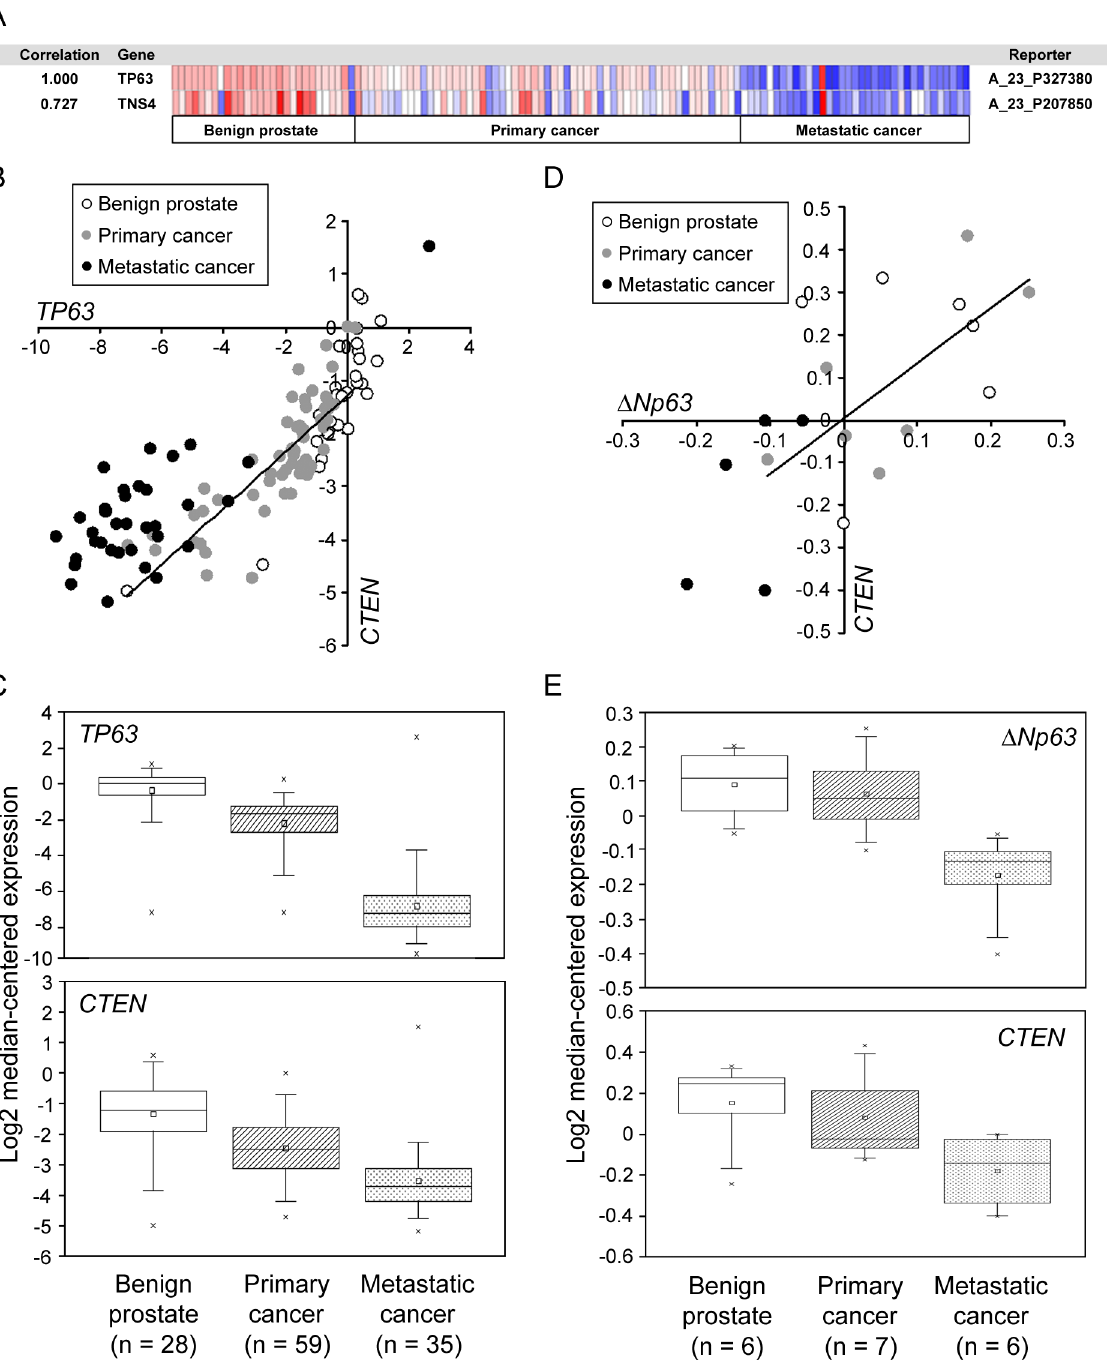
Fig 1. Positive correlation between p63 and CTEN expression in human prostate tissues. (A) The Grasso prostate dataset was analyzed. We used the following filters: gene “ TP63 ” , analysis type, and “ coexpression analysis ” . Color changes according to different expression levels from the least (blue) to the most (red) are shown with fluctuating color intensity. CTEN ( TNS4 ) shows a correlation with TP63 of 0.727 when the maximum correlation is 1. The Grasso prostate dataset is comprised of 19574 genes measured in 122 patients, including 28 benign prostate tissue specimens, 59 primary localized prostate carcinoma and 35 metastatic prostate cancer samples. (B) The expression values of CTEN and TP63 in the Grasso prostate dataset are plotted and the graph shows a positive linear correlation. (C) A box-and-whisker plot that represents TP63 and CTEN expression from primary tumors to metastatic lesions in the Grasso prostate dataset. The horizontal line that forms the top and the bottom of each box represents the 75th and the 25th percentile, respectively. The band that intersects the box is the median value and the square represents the mean value. Horizontal lines (whiskers) above and below the box represent maximum and minimum values, respectively. The cross represents an outlier, which is a value greater or lower than the value represented by the top or